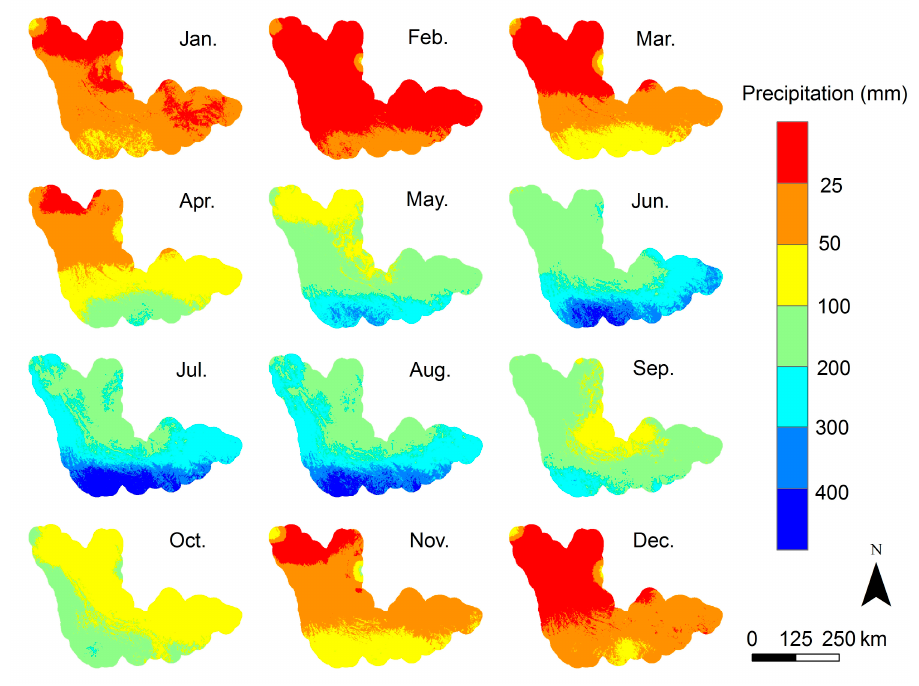
Figure 11. Downscaled average monthly precipitation during 2001–2015 with a 1-km resolution.